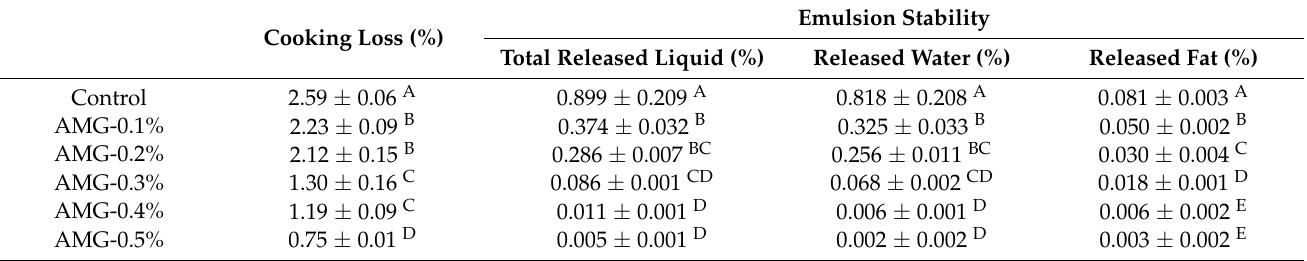
Table 3. Cooking loss (%) and emulsion stability (%) of frankfurters with or without AMG at different